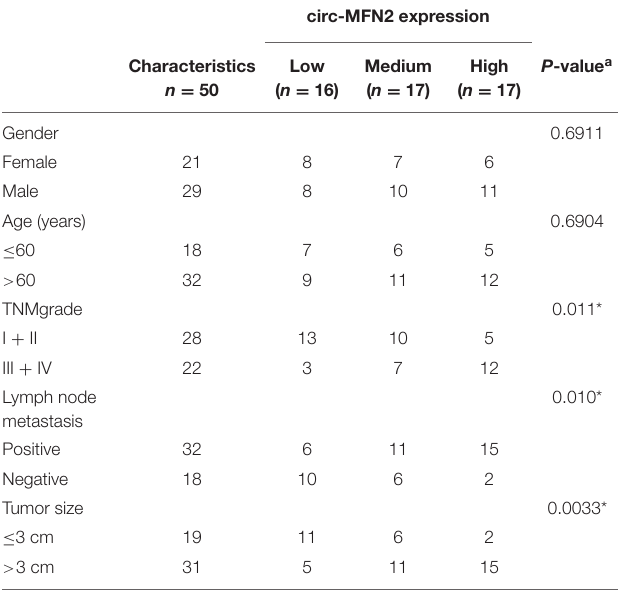
TABLE 1 | Relationship between circ-MFN2 expression and clinicopathologic features of colorectal cancer patients. circ-MFN2 expression